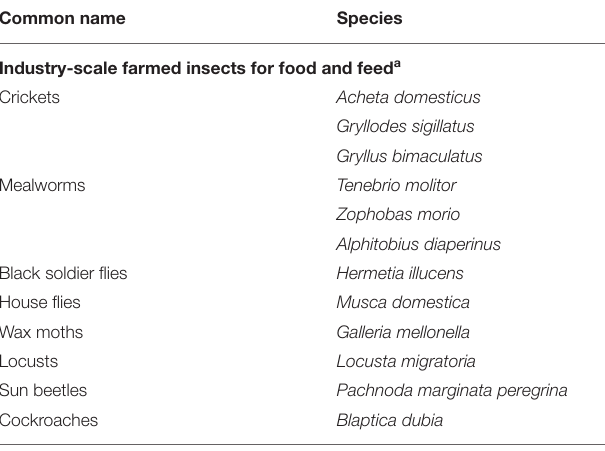
TABLE 1 | Commonly farmed insects for food and